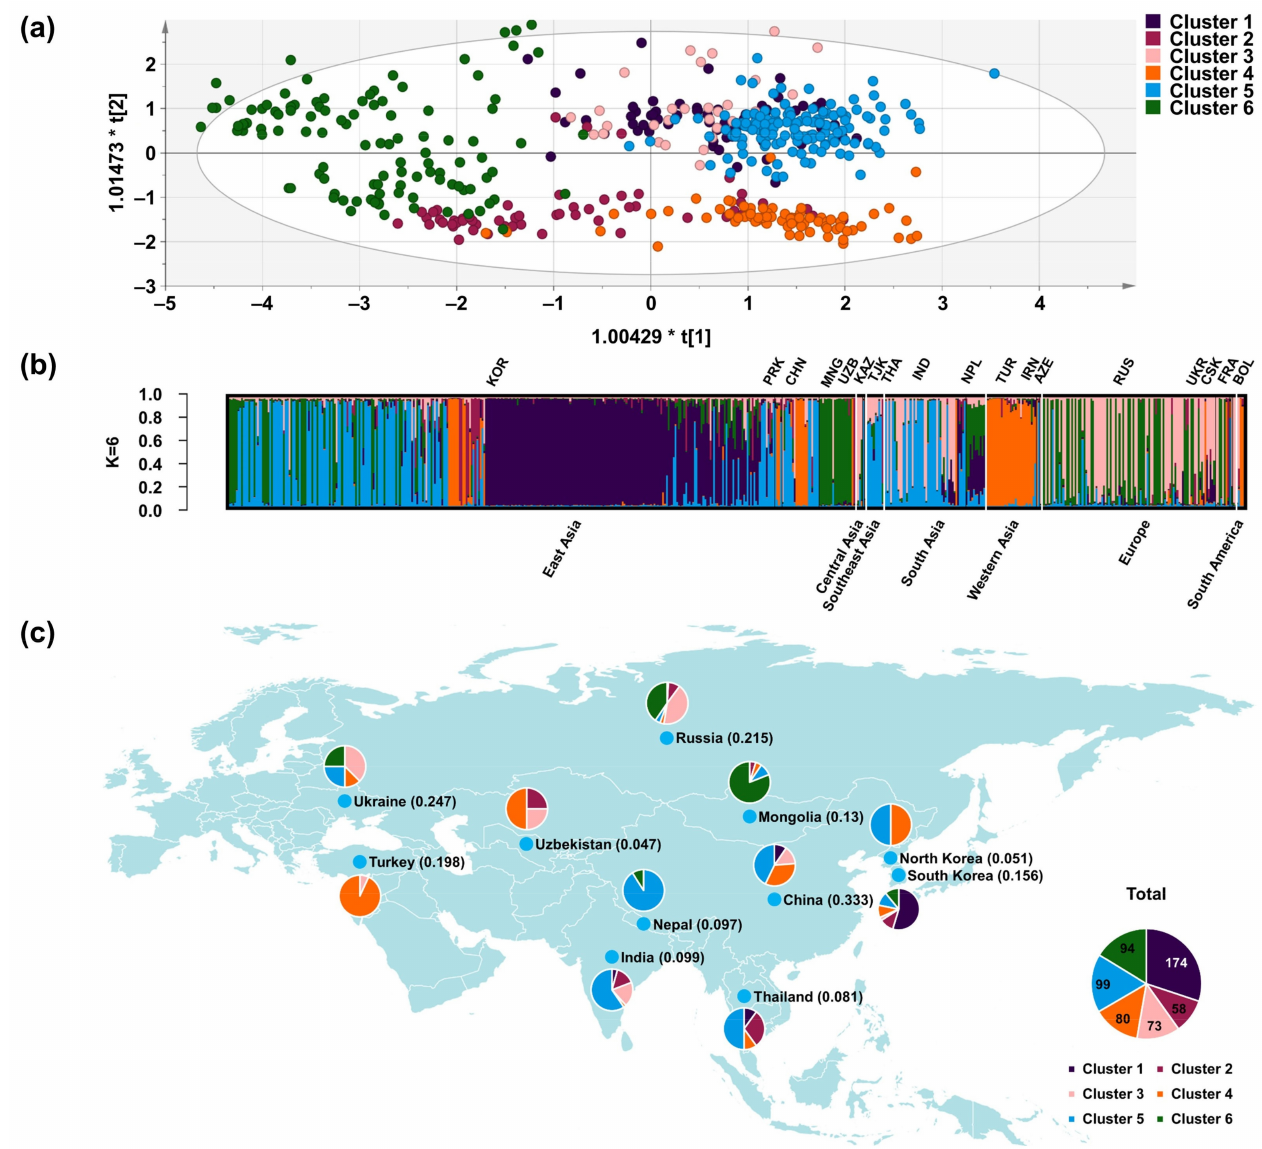
Figure 3. Population structural analysis and orthogonal partial least-squares discrimination analysis (OPLS-DA) plot. ( a ) OPLS-DA plot of six clusters. ( b ) Population structure plot for K = 6. ( c ) Geographical distribution of Eurasian germplasm showing the proportions of the six clusters in each region of origin, inferred by phylogenetic